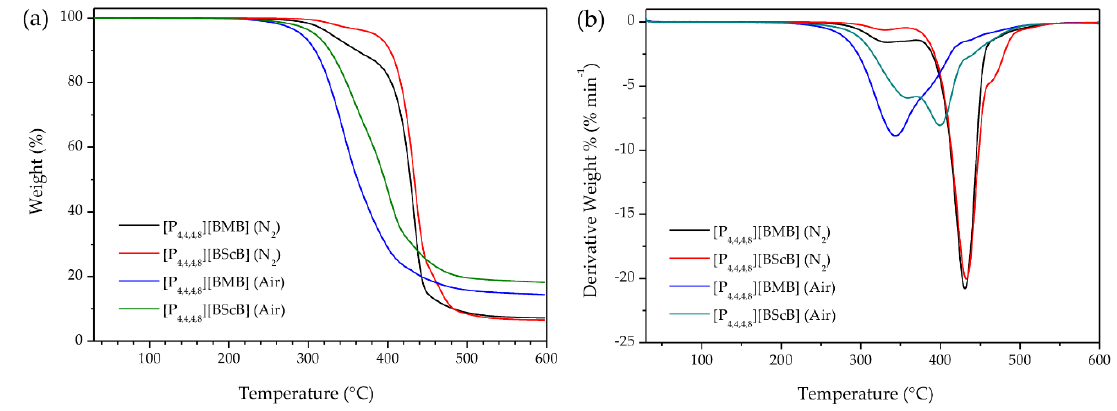
Figure 2. ( a ) TGA thermograms and ( b ) DTG curves of ILs under nitrogen atmosphere and in air at a heating rate of 10 °C min −1 .